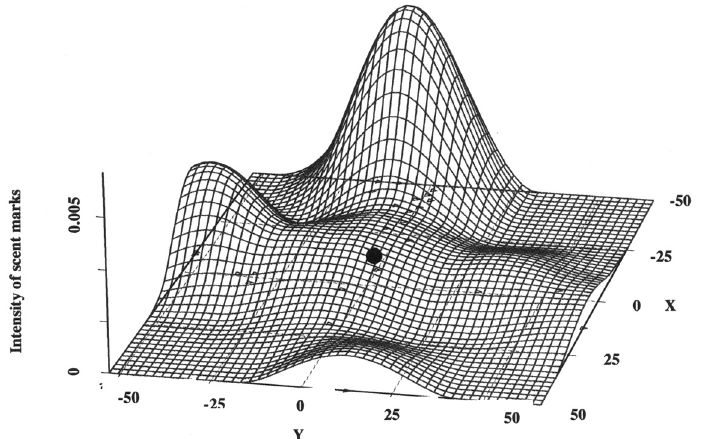
Figure 2. Three-dimensional representation of klipspringer scent marks in the Kruger Nation- al Park to show the distribution of scent marks. The black dot shows the centre of the